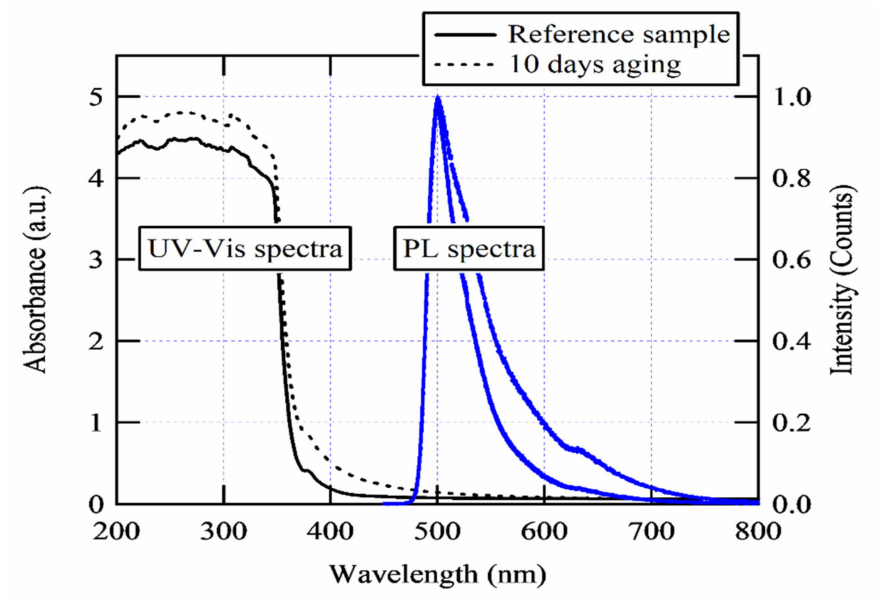
Figure 10. UV-Vis spectra and PL spectra of transformer oil samples with different aging